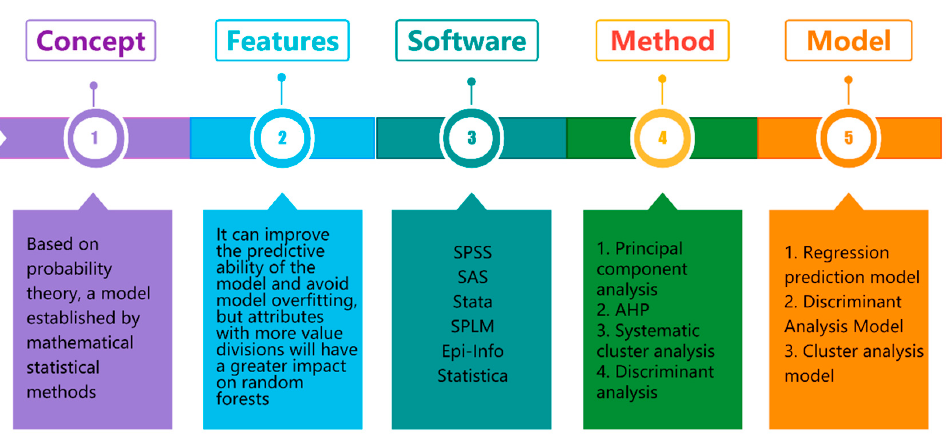
Figure 17. Statistical model. Table 7. Typical cases of statistical models in landslide disaster